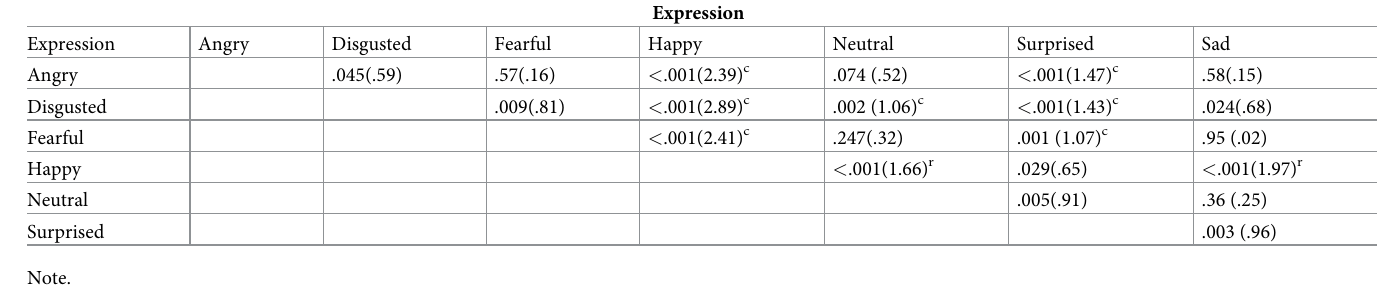
Table 2. P values (effect sizes in parentheses) from paired-sample t-tests between each pair of expressions at -15 degrees eccentricity, for the recognition task. Expression